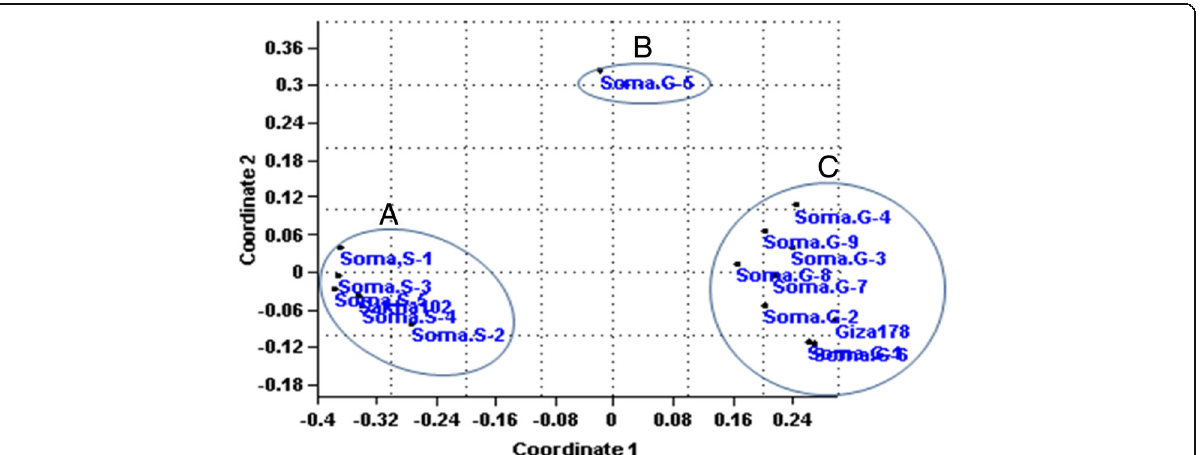
Fig. 5 The scatter plot of principal coordinate analysis (PCoA) based on the RAPD data. The accessions in ellipses A, B, C are from groups I and